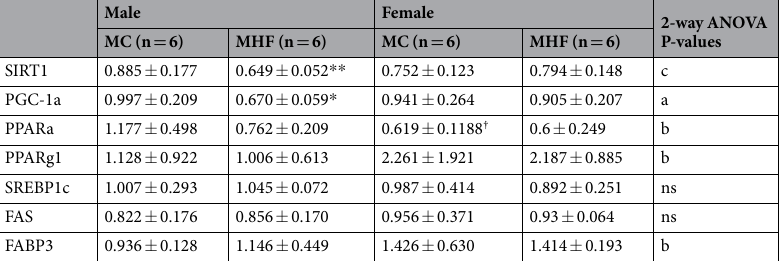
Table 3. mRNA expression of lipid metabolism markers in offspring kidney. MC (offspring of dams fed chow); MHF (offspring of dams fed high-fat diet). SIRT1 ( Sirtuin1); PPAR γ (Peroxisome proliferator-activated receptor gamma); PPAR α (Peroxisome proliferator-activated receptor alpha); PGC-1 α (PPAR γ coactivator 1-alpha); FAS (Fatty acid synthase); SREBP-1c (Sterol regulatory element-binding protein); Fatty acid binding protein (FABP) 3. Results are expressed as means ± SD. Data were analysed using two-way ANOVA with Bonferroni post hoc test. * P < 0.05, ** P < 0.01 (vs MC offspring), † P < 0.05 (vs male offspring). a (P < 0.05, Maternal diet effect), b (P < 0.5, Sex effect), c (P < 0.05, interaction